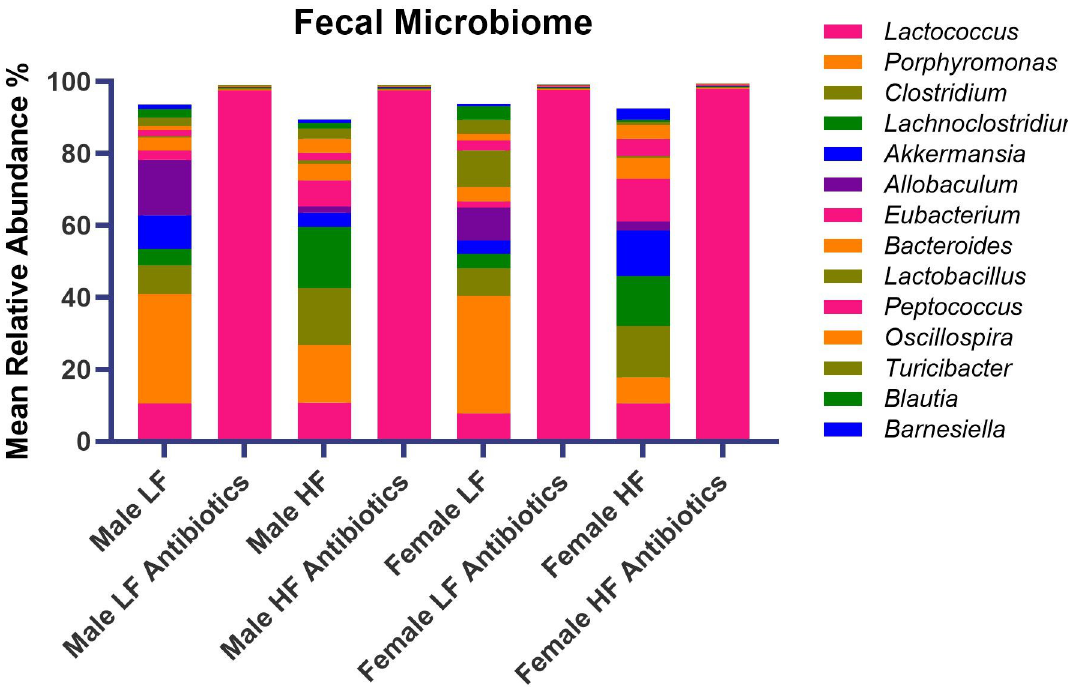
Fig 5. Genus-level relative abundances in the fecal microbiome (n = 6/group). Average relative abundance for the top 14 most abundant genera are displayed for each of the 8 experimental